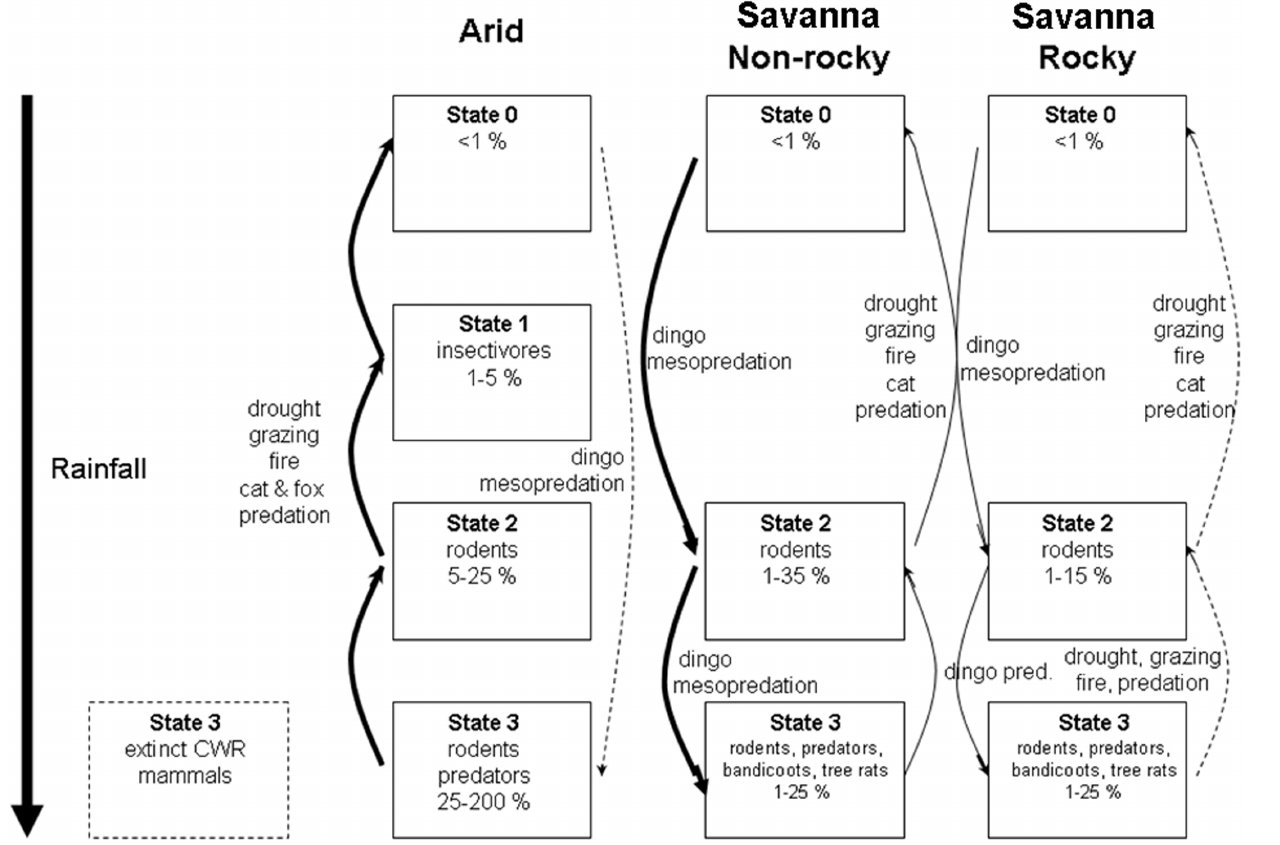
Figure 6. State-and-transition models for assemblages of small- and medium-sized mammals in arid and savanna habitats. States are indicated by rectangles and transitions that drive state-changes are shown by arrows. Solid arrows are known transitions, dotted arrows represent putative transitions identified in the present work. The arid model is based on Letnic and Dickman [12], the savanna models on the results of the present study. Percentage values within rectangles represent average total trap success rates for species within the respective states. State I (comprising insectivorous marsupials) is absent from the Kimberley savannas, whereas several critical weight range (CWR: 35–5500 g) mammals that were part of State 3 assemblages in arid habitats, but which are now extinct, are shown in the rectangle defined by the dashed line.